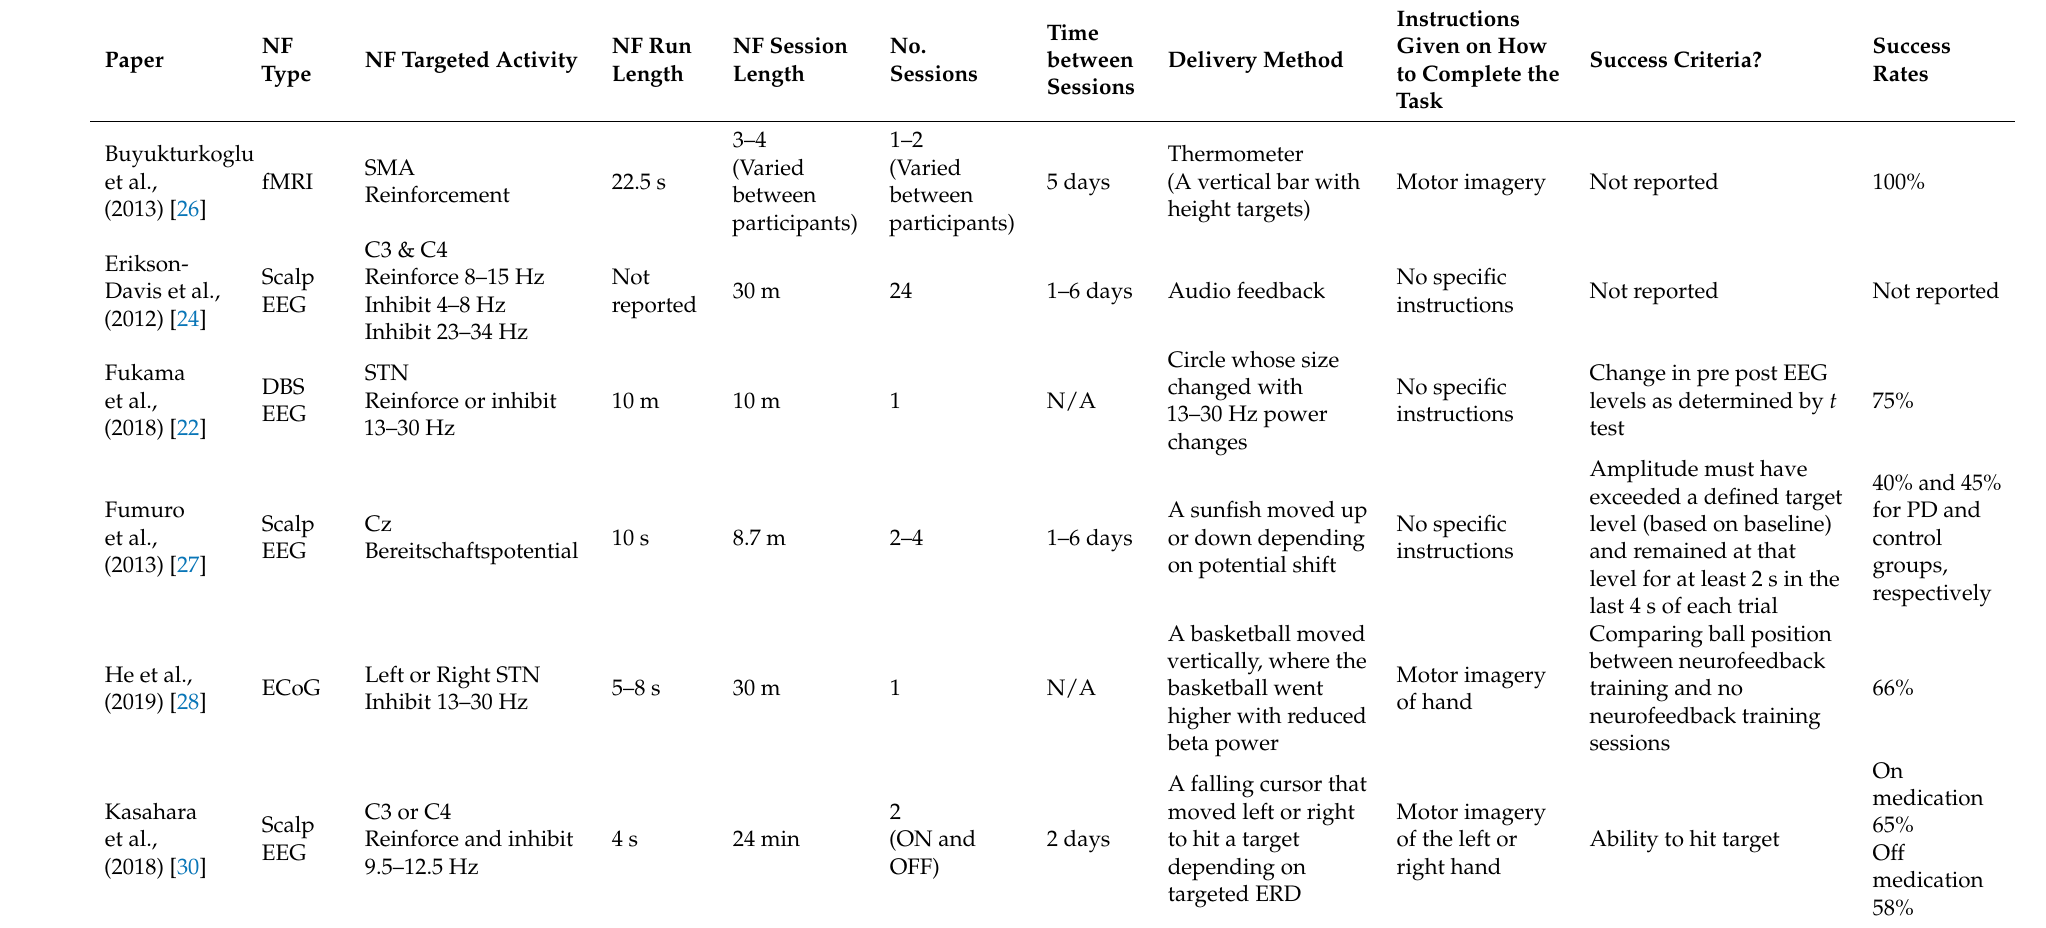
Table 4. Details of neurofeedback training, regime, and